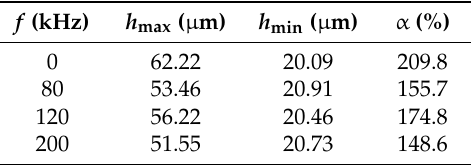
Table 1. Dependence of α on ultrasonic